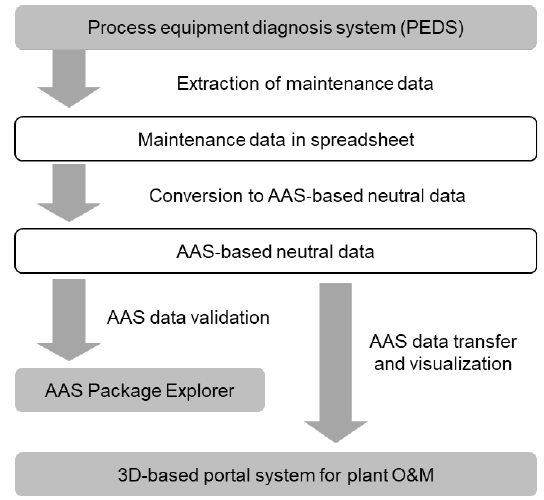
Figure 12. AAS-based data exchange procedure in the experiment.